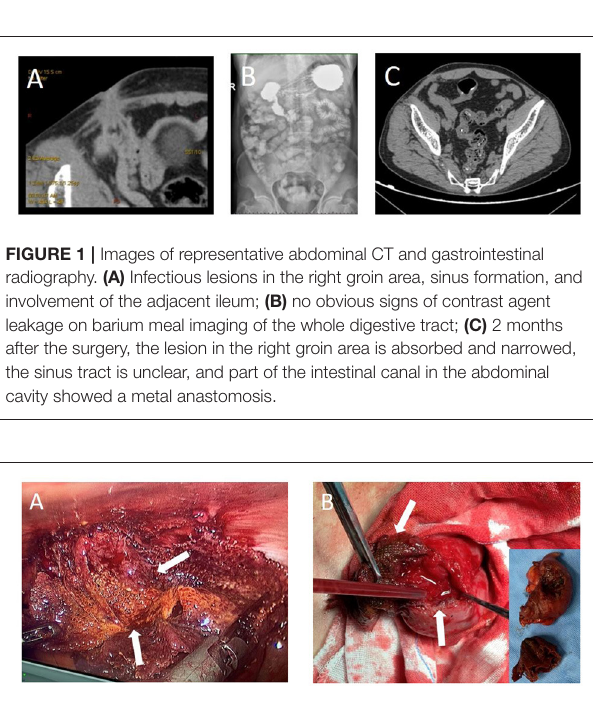
FIGURE 2 | Intraoperative photographs. (A) Laparoscopic mesh and part of the ileum (white arrow), (B) Laparotomy mesh and part of the ileum (white arrow), and the embedded image shows the excised mesh and partial ileum